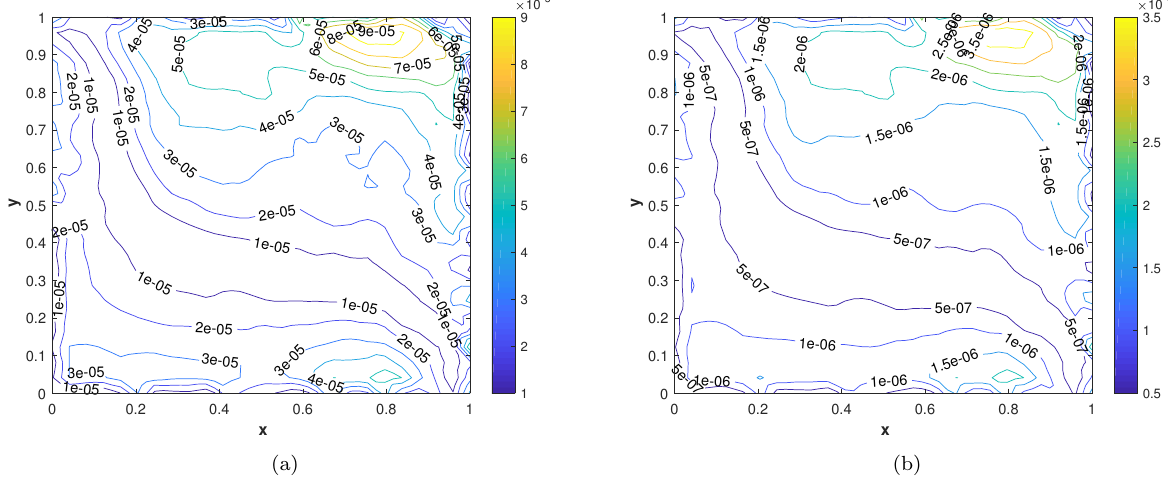
Figure 11: (a) Contour plot of Ab Error . (b) Contour plot of Rms Error .